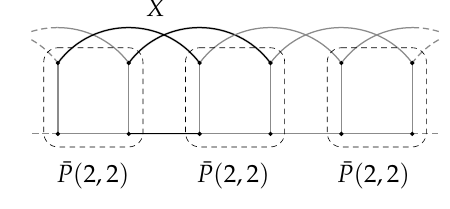
Figure 2. P ( 2 n ,2 ) as a rotagraph.